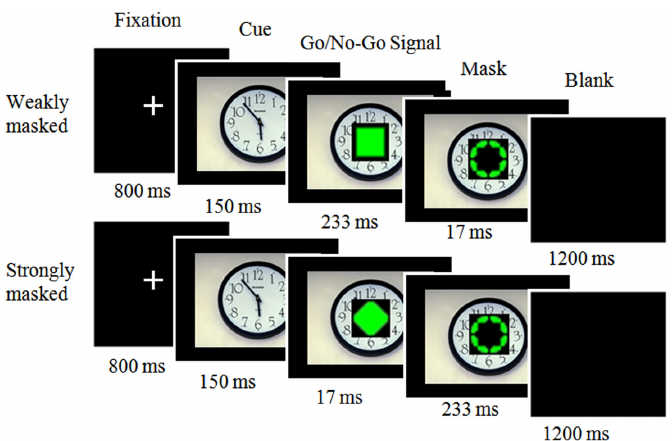
Fig 1. Procedure and design of Experiments. Participants were engaged in a masked Go/No-Go task superimposed on fearful, disgusting, or neutral emotional contexts.